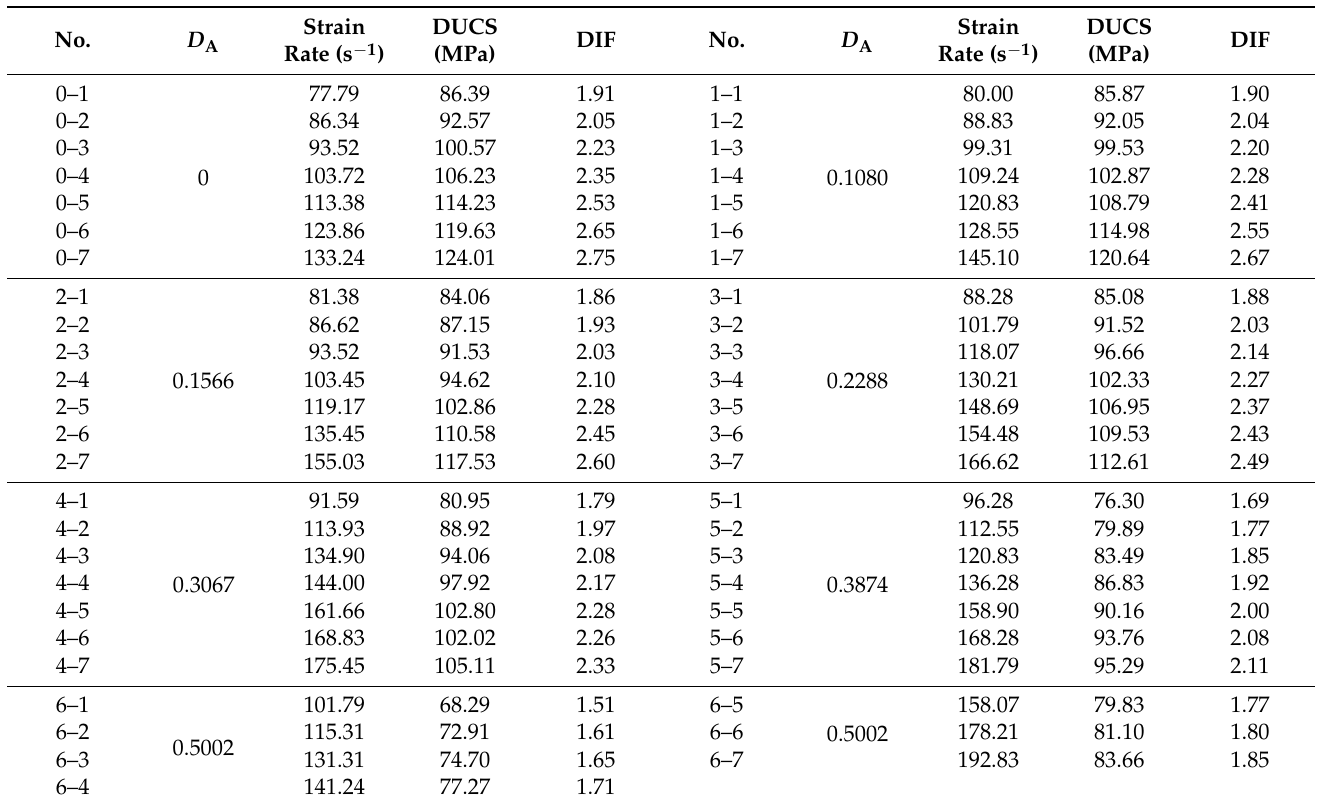
Table 2. Results of the dynamic uniaxial compression tests.